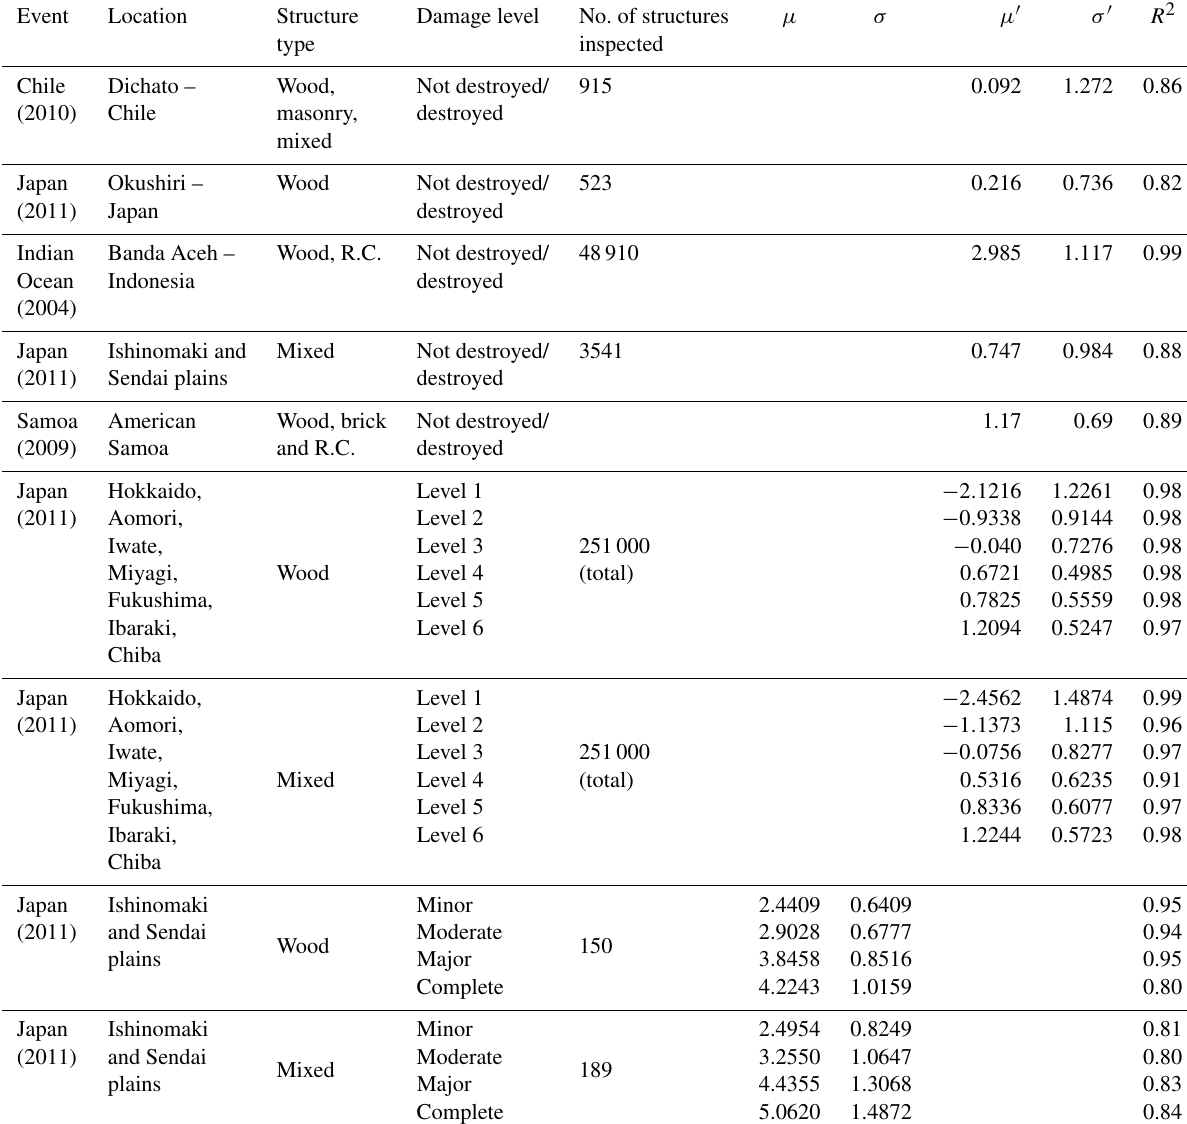
Table 2. Summary of statistical parameters and damage levels for empirical fragility curves (Mas et al., 2012; Suppasri et al., 2012b, 2013) including the current case of Coquimbo. µ and σ are statistical parameters for normal distribution, while µ (cid:48) and σ (cid:48) are the same parameters for lognormal distribution. R.C. indicates reinforced concrete